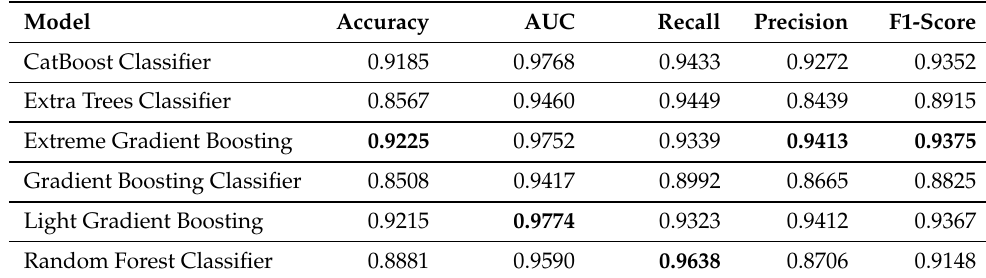
Table 5. Test dataset results (best scores in bold).